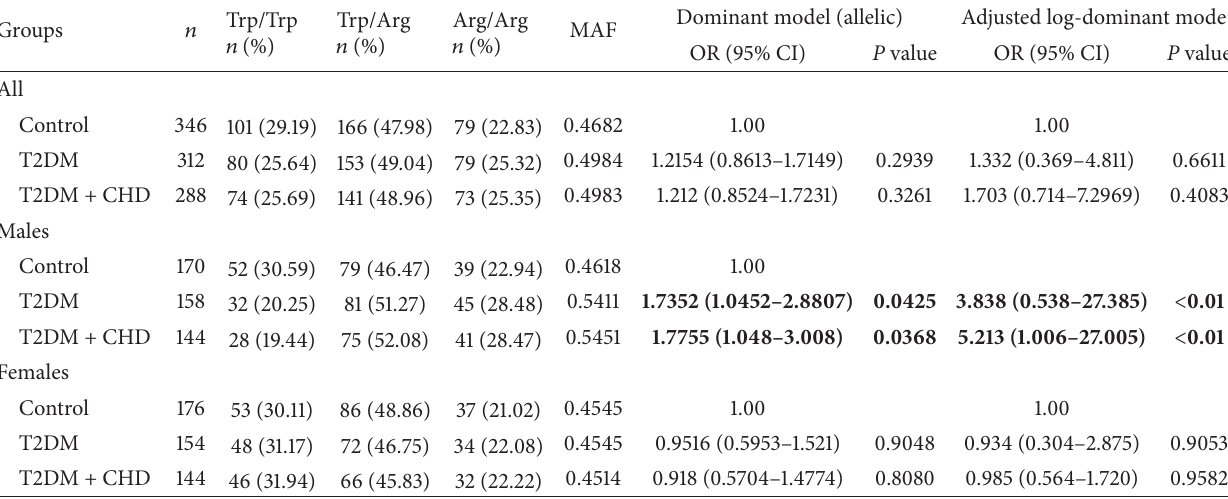
Table 2: Correlation of T2DM and T2DM + CHD estimated by binary regression